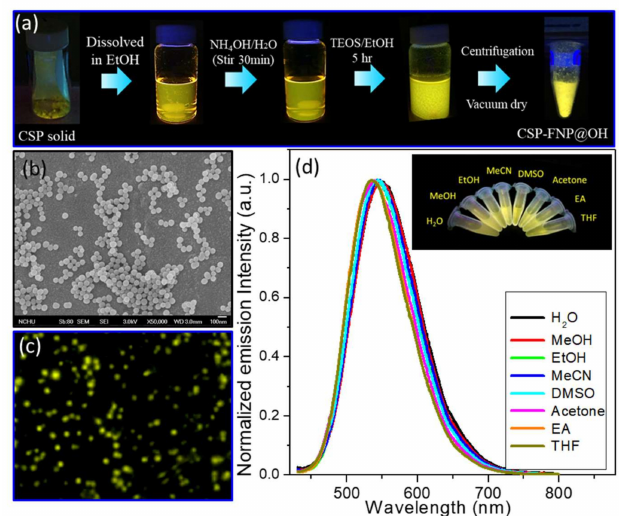
Figure 4. ( a ) Preparation scheme of CSP-SN@OH from CSP; ( b ) SEM images (scale bar 100 nm); ( c )fluorescencemicroscopyimage(Ex: 390 ± 20nmbpfilter;Em: 410nmlpfilter)and( d )solvent-independent emission spectra of CSP-SN@OH in various solvents. The inset photos show the emission color under a handheld ultraviolet lamp (365